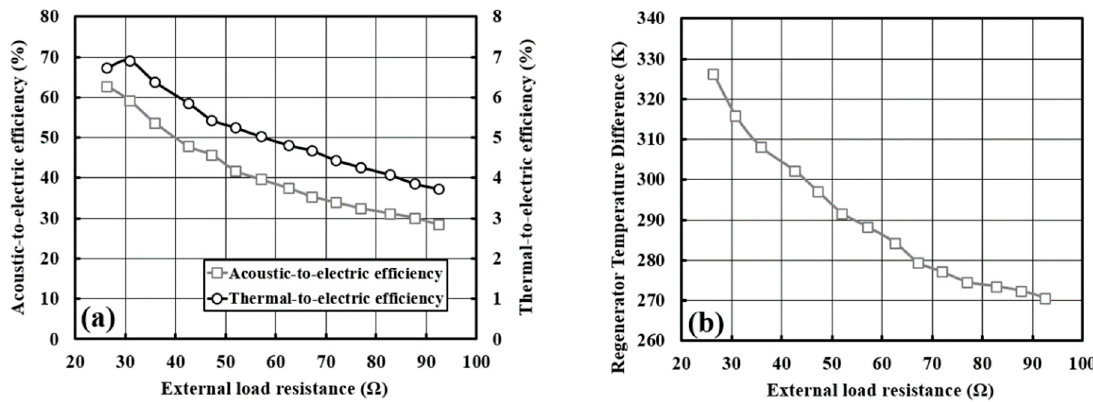
Figure 6. ( a ) Acoustic-to-electric and thermal-to-electric e ffi ciencies vs. load resistance; ( b ) Temperature Figure 6. (a) Acoustic-to-electric and thermal-to-electric efficiencies vs. load resistance; (b) di ff erential across the regenerator vs. load resistance. Heating power is 900 Temperature differential across the regenerator vs. load resistance. Heating power is 900 W.